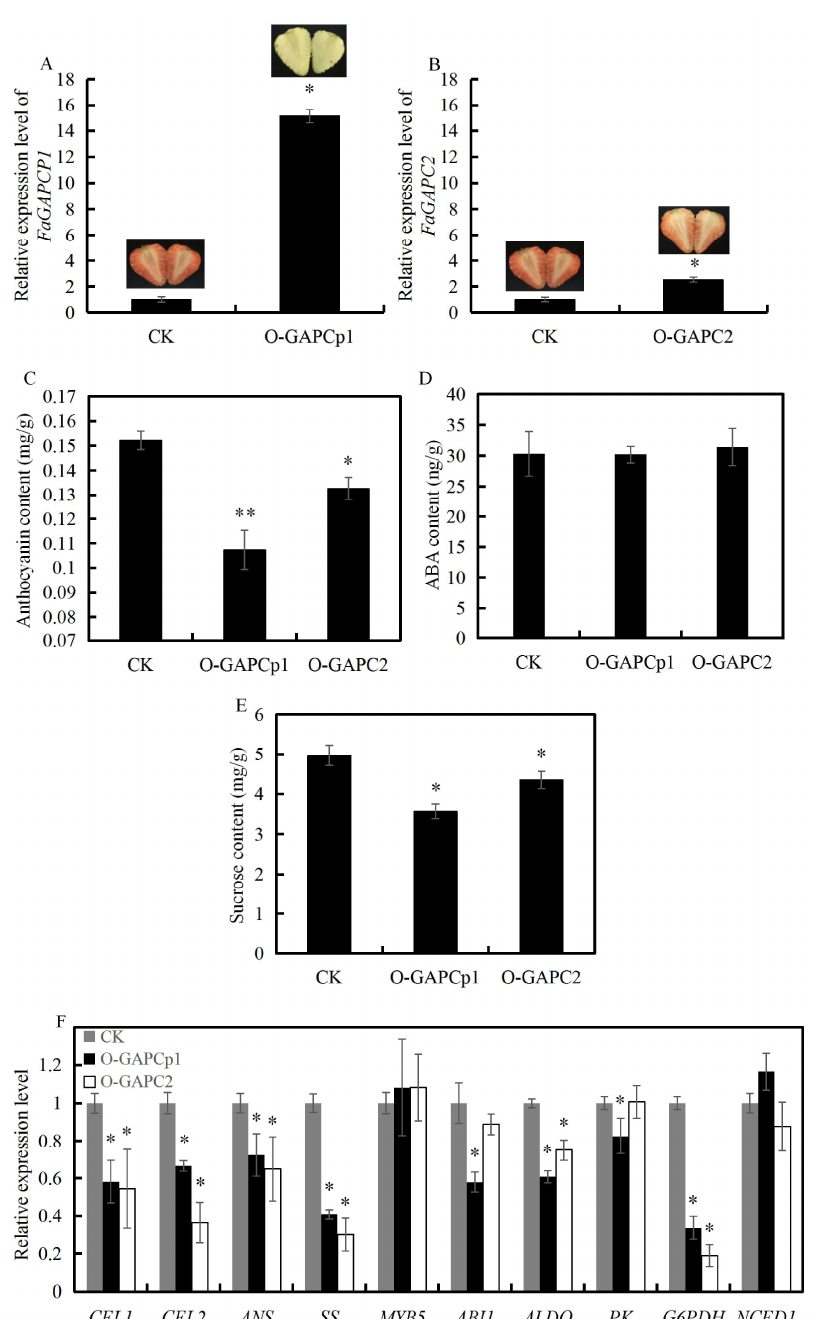
Figure 4. Overexpression for the FaGAPC2 and FaGAPCp1 genes in strawberry fruits. ( A ) Transcript levels of FaGAPCp1 in the control, FaGAPCp1 overexpression fruit by qRT-PCR; ( B ) transcript levels